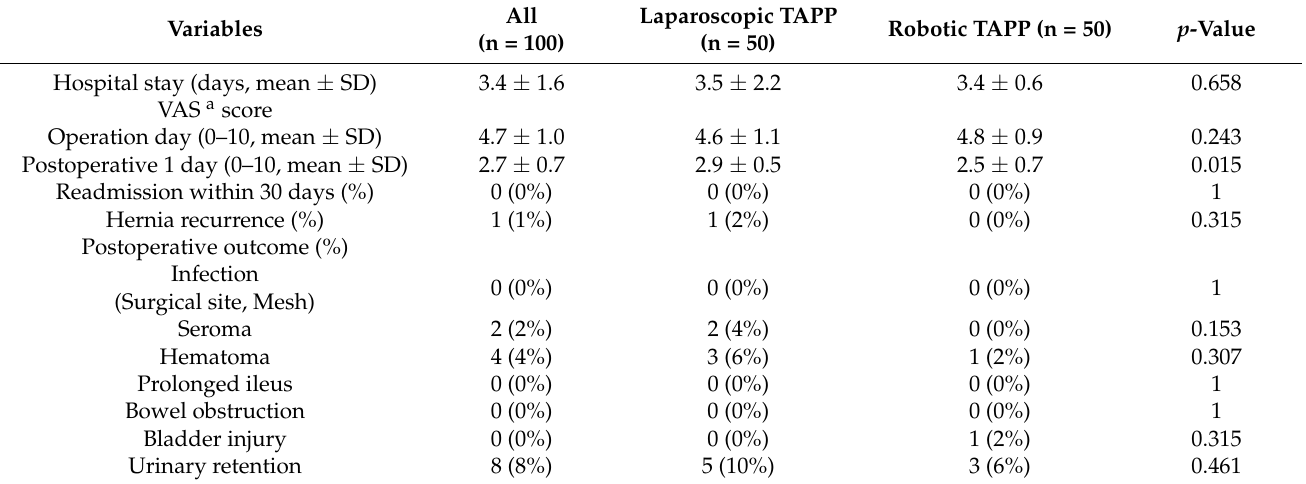
Table 3. Postoperative outcomes.